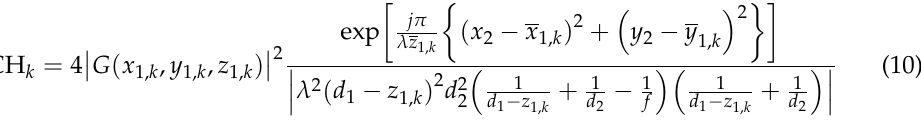
at the kth layer is simplified to